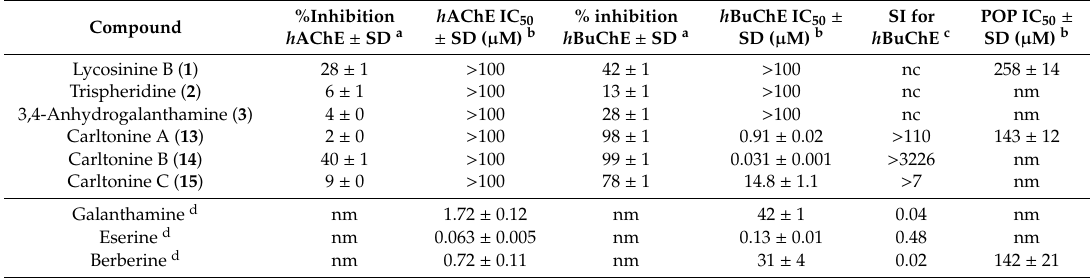
Table 2. In vitro results of h AChE, h BuChE and POP inhibition of selected AAs isolated from Narcissus pseudonarcissus cv. Carlton.